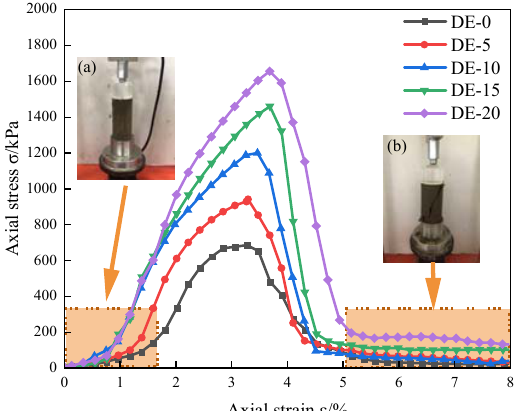
Figure 4. Stress–strain curves of coastal cement soil modified with different amounts of diatomite. ( a ) and ( b ) are the initial and failure images of specimens, respectively.